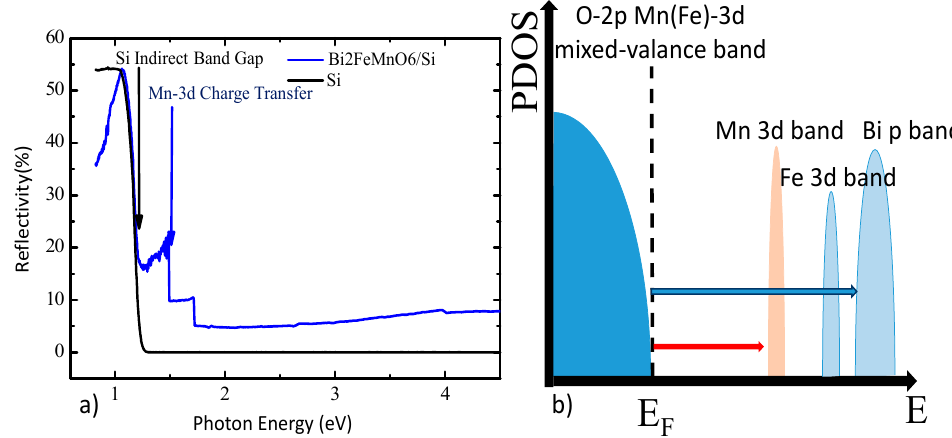
Figure 1. ( a ) The reflection spectrum of Bi 2 FeMnO 6 film. A reflection spectrum of Si was used as a reference, and the sample signal is multiplied by 5 times for a visual guide. ( b ) Schematically shows the electronic band structure of Bi 2 FeMnO 6 .